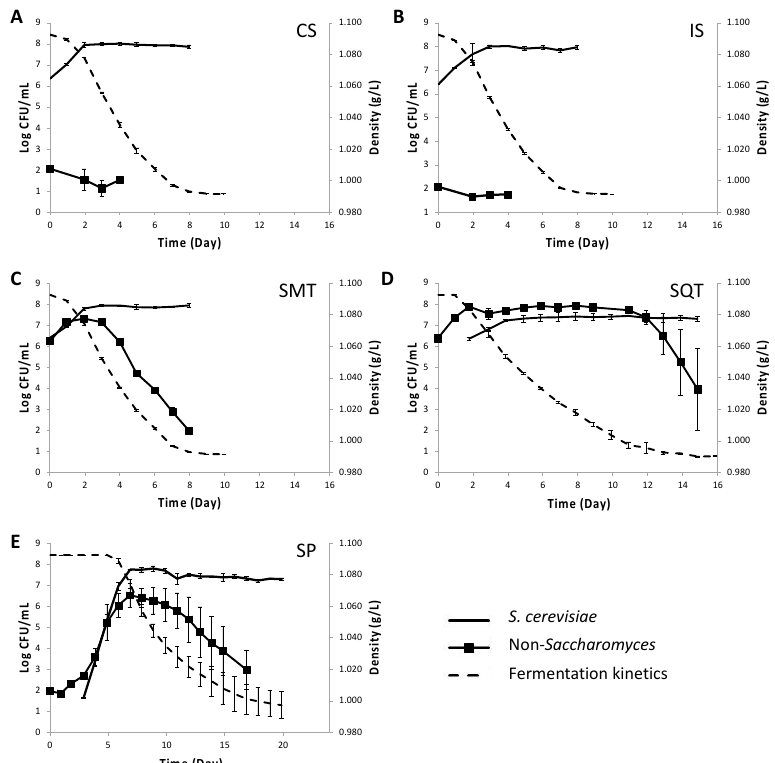
Figure 3. Kinetics of microvinifications (dashed line) and yeast population dynamics (continuous line) in must inoculated with commercial S. cerevisiae ( A ), S. cerevisiae ScS13 ( B ), simultaneously inoculated T. delbrueckii TdS6 and S. cerevisiae ScS13 ( C ), sequential inoculated T. delbrueckii TdS6 and S. cerevisiae ScS13 ( D ) and in non-inoculated must ( E ). ESA medium was used for enumeration of S. cerevisiae (-) and LA medium for enumeration of non- Saccharomyces yeasts ( ■ ).